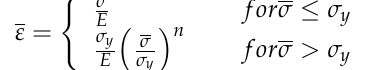
Table 3. The J–C failure model parameters for the developed materials. D 1